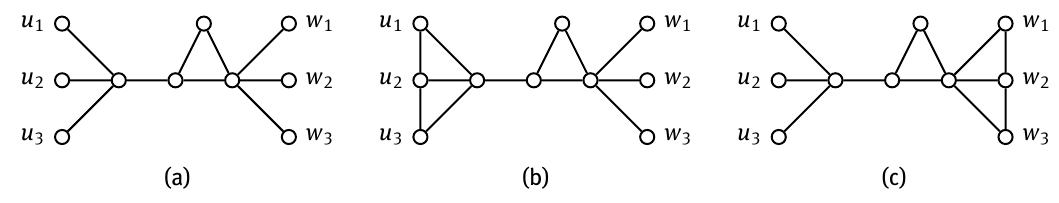
Figure 2: (a) A graph with isolated twin set { u 1 , u 2 , u 3 } and { w 1 , w 2 , w 3 } that are the same size and with degree 1 . By adding 2